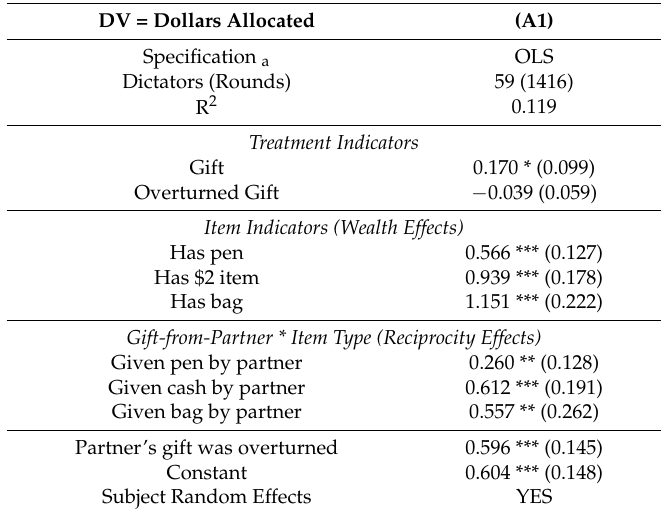
Table A2. Allocation by Type of Gift Received (Includes Caltech Session).